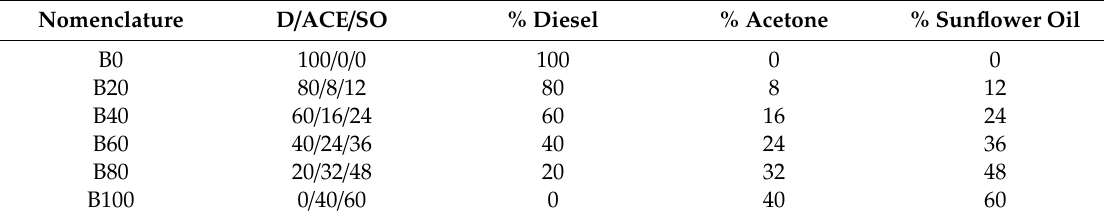
Table 5. Diesel / acetone / sunflower oil blends containing 40% acetone.